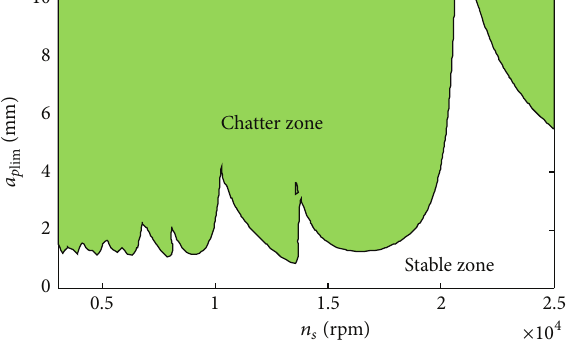
Figure 7: SLD of milling process.